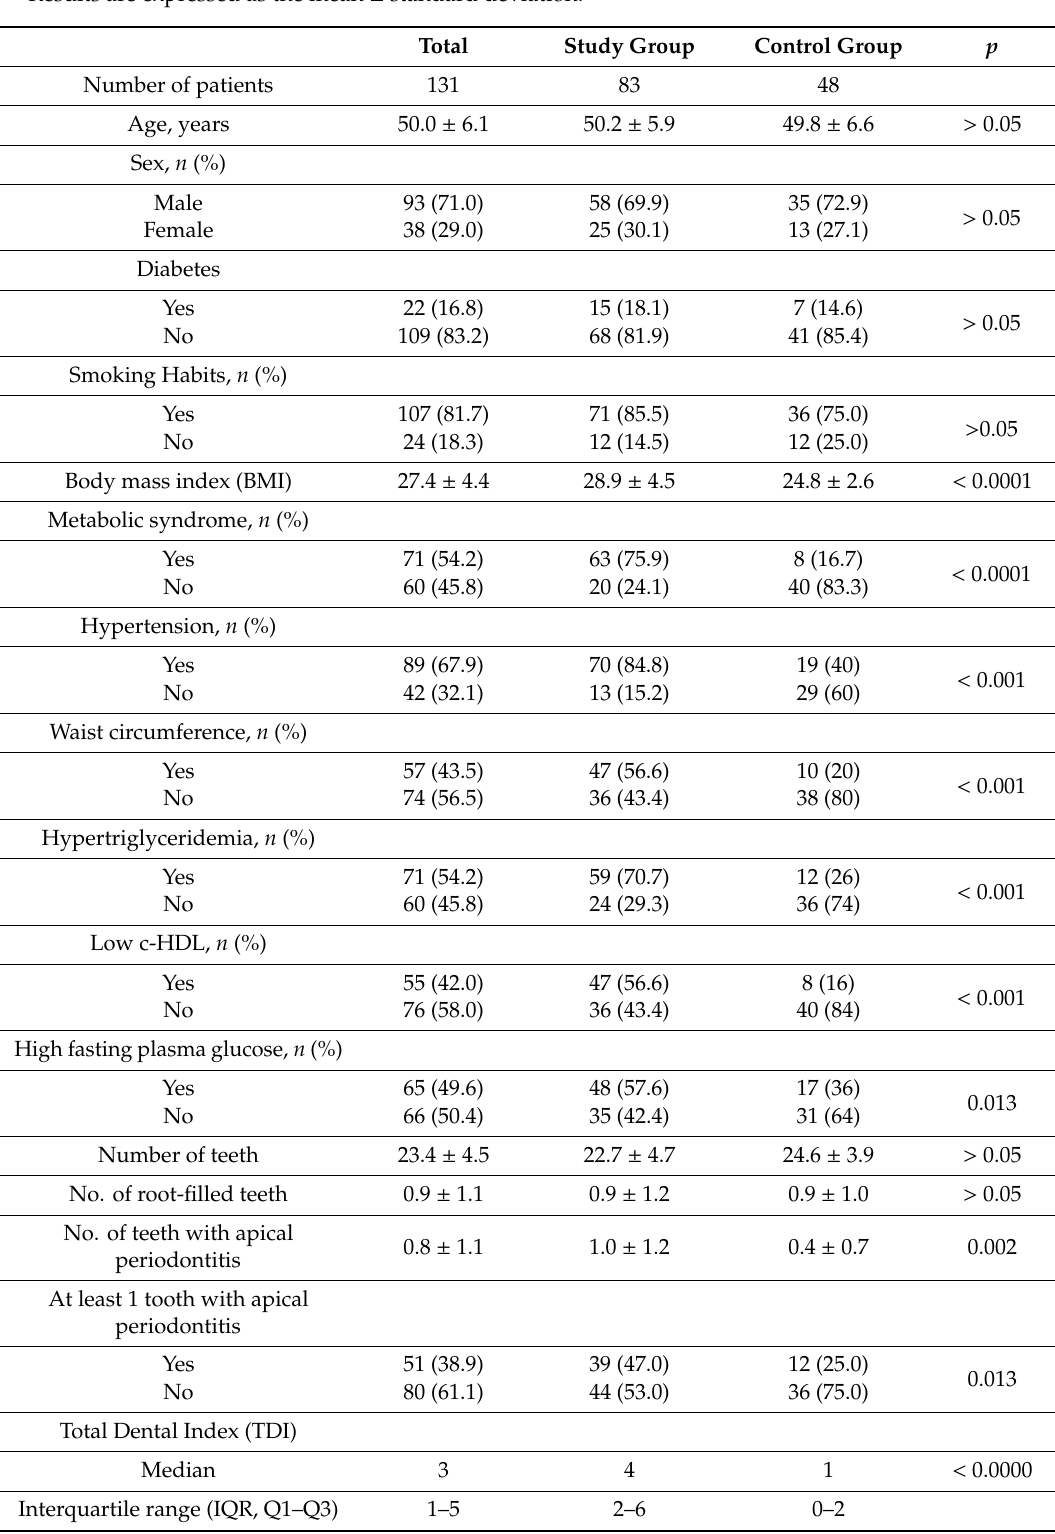
Table 2. Characteristics and dental status of the patients included both in the study and control groups. Results are expressed as the mean ± standard